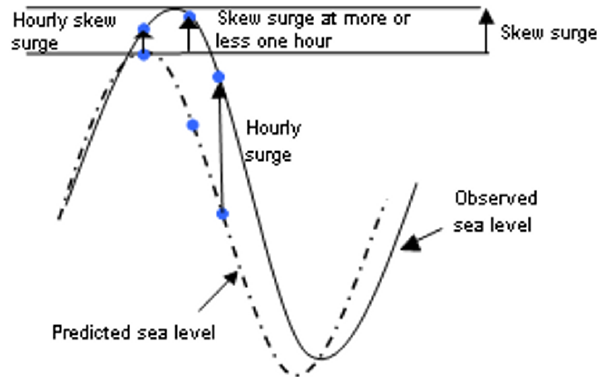
Fig. 5. Definitions of the different surges, with an hourly sampling. In this scenario, the observed tide signal is shifted in time in refer- ence to the predicted tide